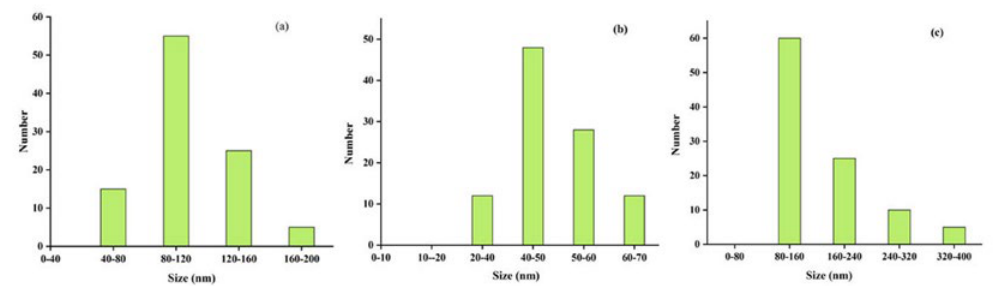
Fig. 10. Particle size histogram of CuO nanoparticles for [Cu(BDC)(bipy)](BDCH